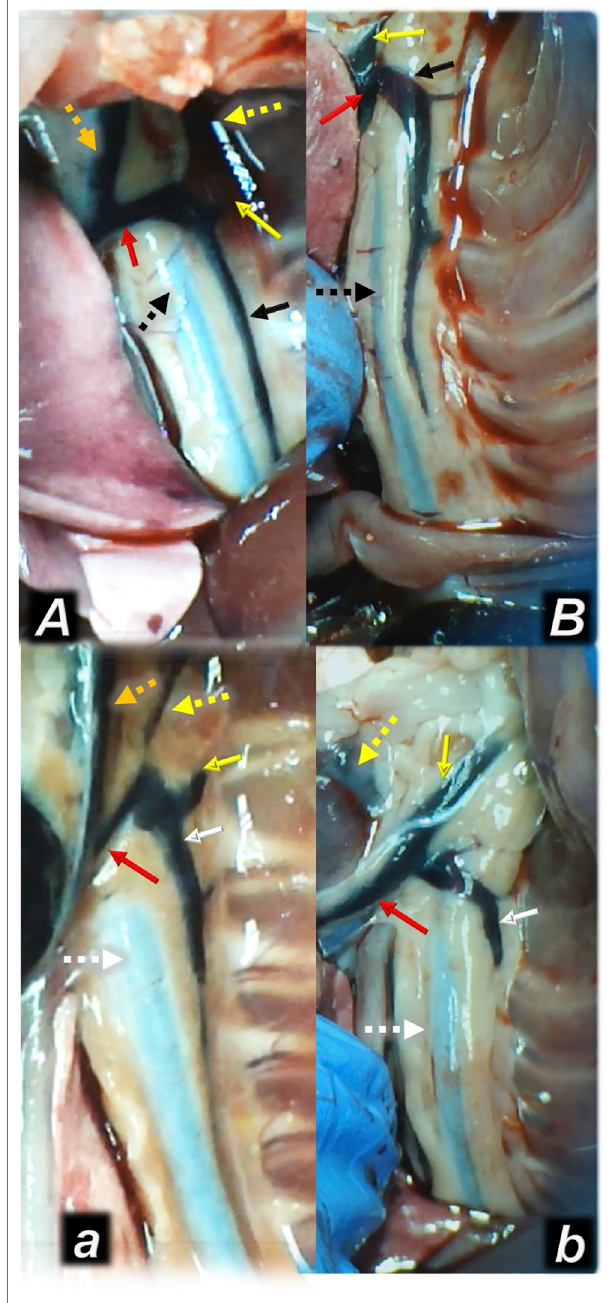
FIGURE 4 | Illustrative presentation of the azygos veins after the increasedintraabdominalpressureandmedication(sc)(fullwhitearrow,saline (5 ml/kg,low,poorazygosveinpresentationa,b)orBPC157(fullblackarrow, 10 ng/kg, upper, functioning azygos vein A, B): 40 mmHg (30 min) (a, A) and 50 mmHg (25 min) (b, B). Aorta (dashed arrows (white (control), black (BPC 157), axillar vein (full yellow arrow), left superior caval vein (red arrow), eternal jugular vein (dashed yellow arrow), internal jugular vein (dark yellow dashed arrow). A camera attached to a VMS-004 Discovery Deluxe USB microscope (Veho, United